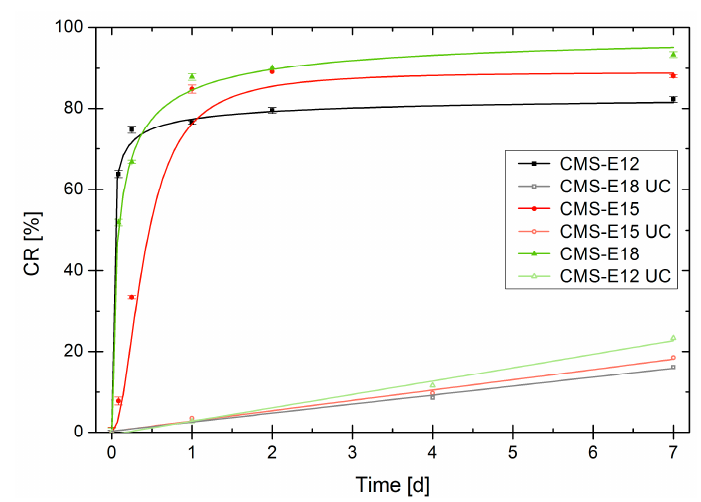
Figure 7. Increase of drug release upon degradation in comparison to the untreated control (UC). CMS nanocarrier concentration 10 mg·mL -1 , n = 3.